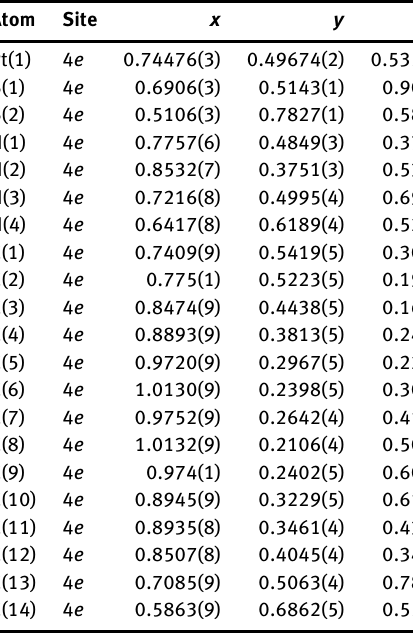
Table 3: Atomic coordinates and displacement parameters (Å 2